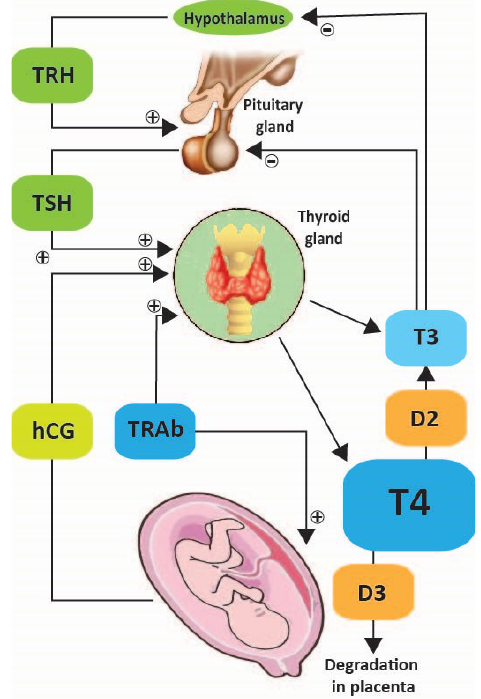
Figure 1. Pregnancy and hypothalamic pituitary thyroid axis. T4—Tetraiodothyronin, T3—Triiodothyronine, TRH—Thyrotropin-releasing hormone, TSH—Tyroid Stimulator Hormone, TRAb—TSH Receptor Auto Antibodies, hCG—human Chorionic Gonadotropin, D3—type 3 iodothyronine deiodinase.